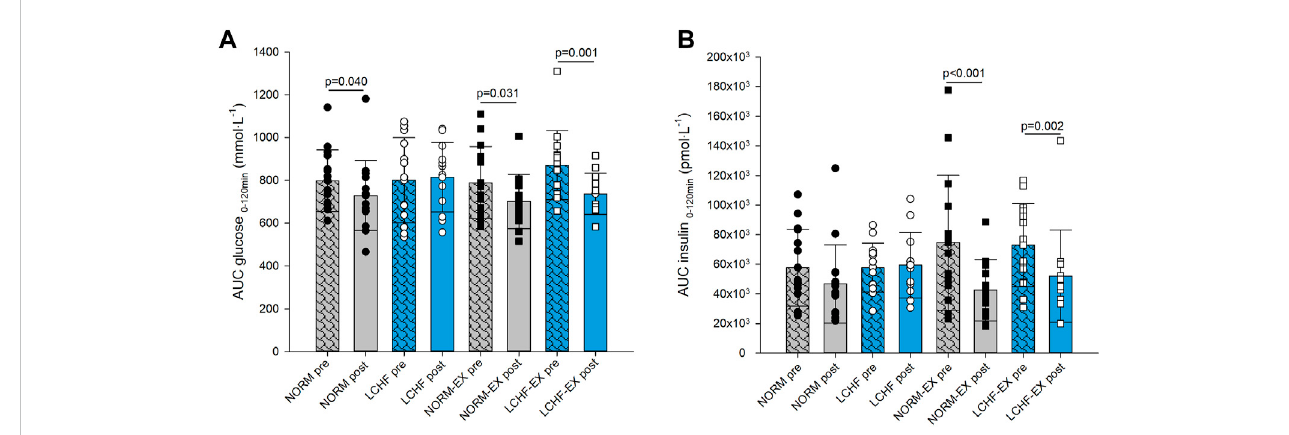
FIGURE 3 Primary outcome glucose tolerance measured as Area Under Curve (AUC) (A) glucose, and (B) insulin, during a 120-min oral glucose tolerance test (OGTT) prior to the intervention (pre) and after (post) the 10-week intervention. NORM, Normal diet; LCHF, Low-carbohydrate high-fat diet; NORM-EX, Normal diet combined with exercise; LCHF-EX, Low-carbohydrate high-fat diet combined with